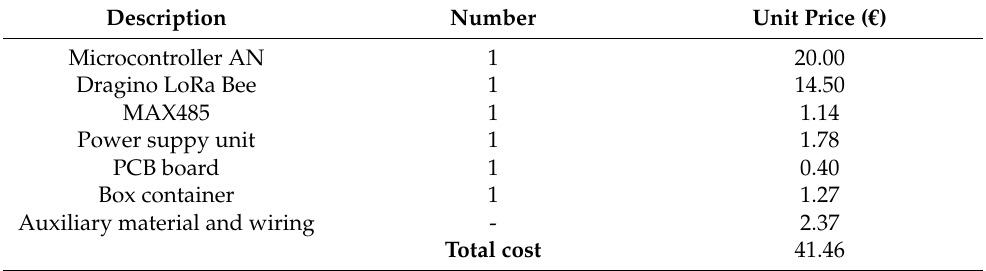
Table 5. Power analyzer monitor and programming device (PAMPD) components